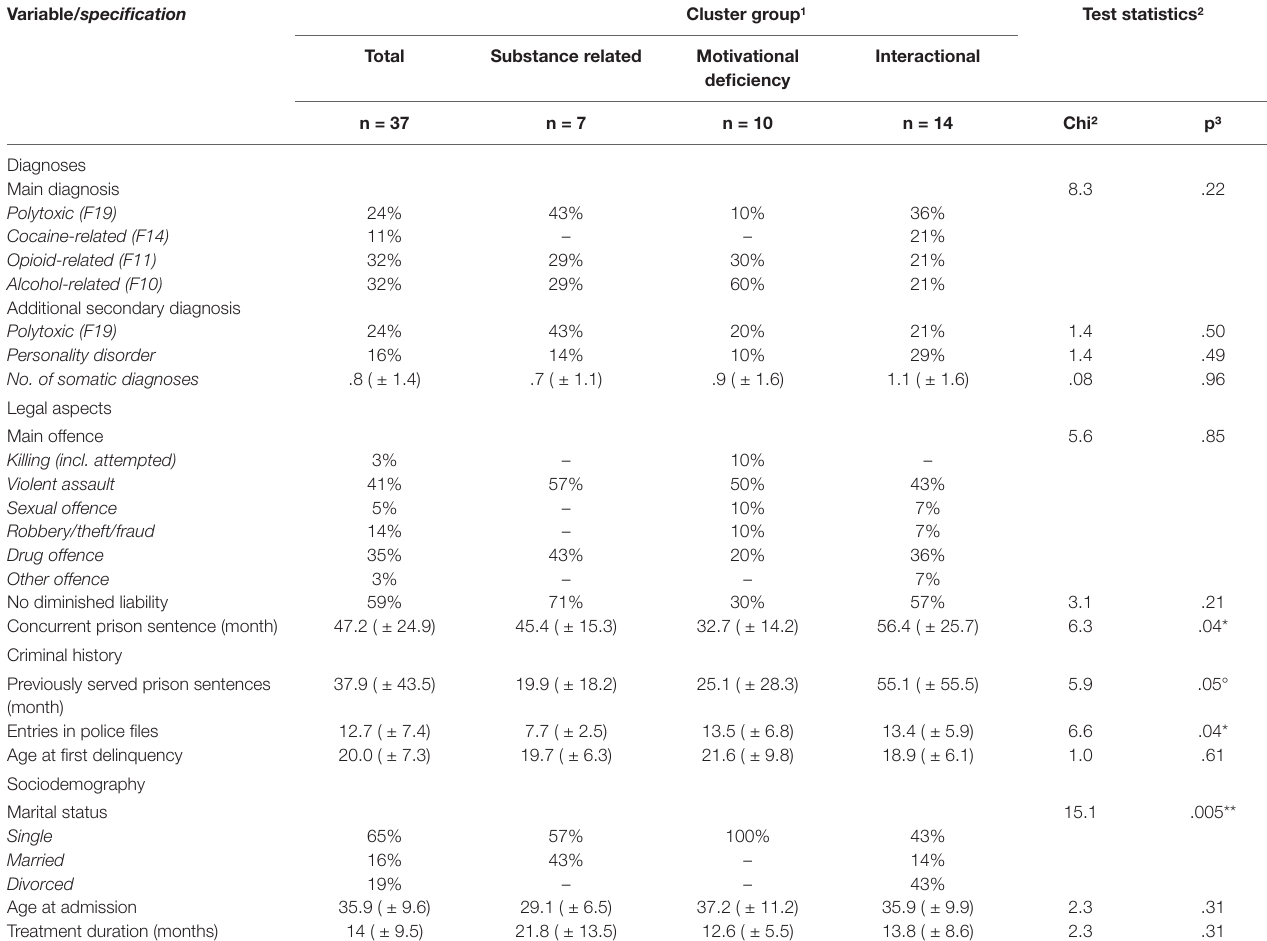
TABLe 2 | Patients’ characteristics according to cluster group; cluster differences